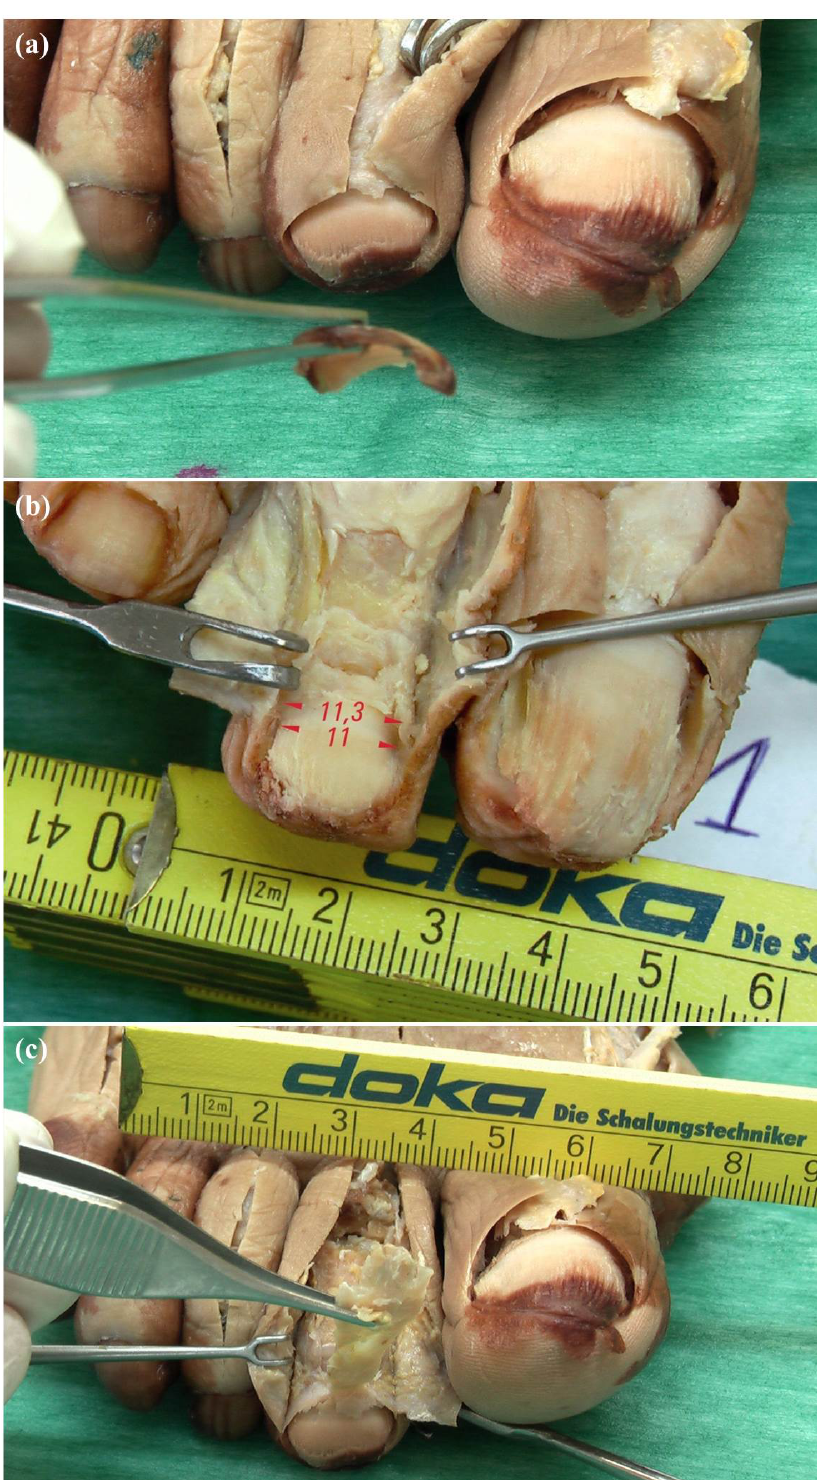
Figure 1. Anatomical study procedure: ( a ) The nail plate was gently elevated and sharply excised from side to side; ( b ) Color and texture of the nail matrix and bed (Red arrows and numbers showed the nail matrix width in mm at the proximal and distal nail parts); ( c ) Exposure of the distal insertion of the extensor digitorum longus (EDL) tendon at the base of distal phalanx until the proximal nail matrix fold was